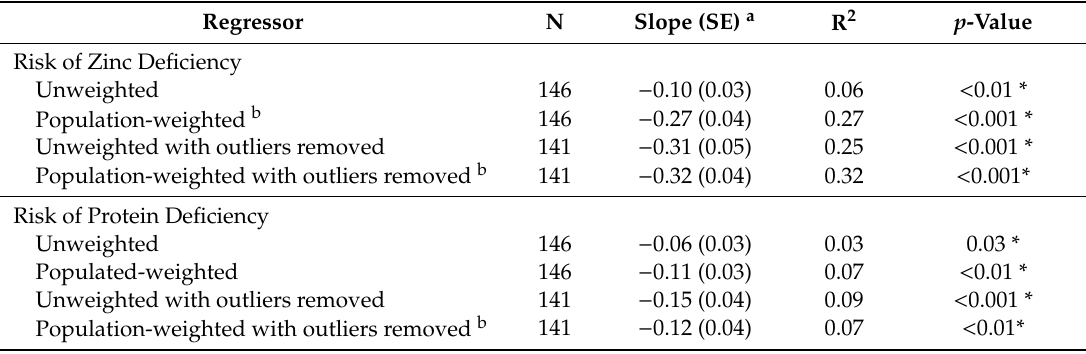
Table 2. Unweighted and population-weighted associations between cumulative per capita CO 2 emissions and increased population newly at risk of zinc and protein deficiency between 2011 and 2050, for 146 countries and for a subset of 141 countries that excludes outlying highest cumulative per capita CO 2 emitters.